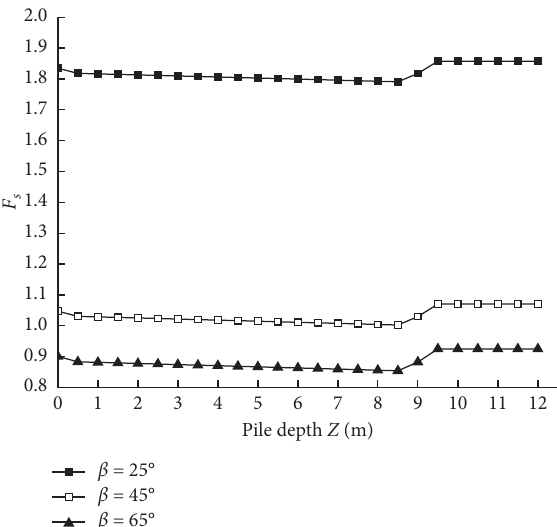
f / L X on the stability of 3D